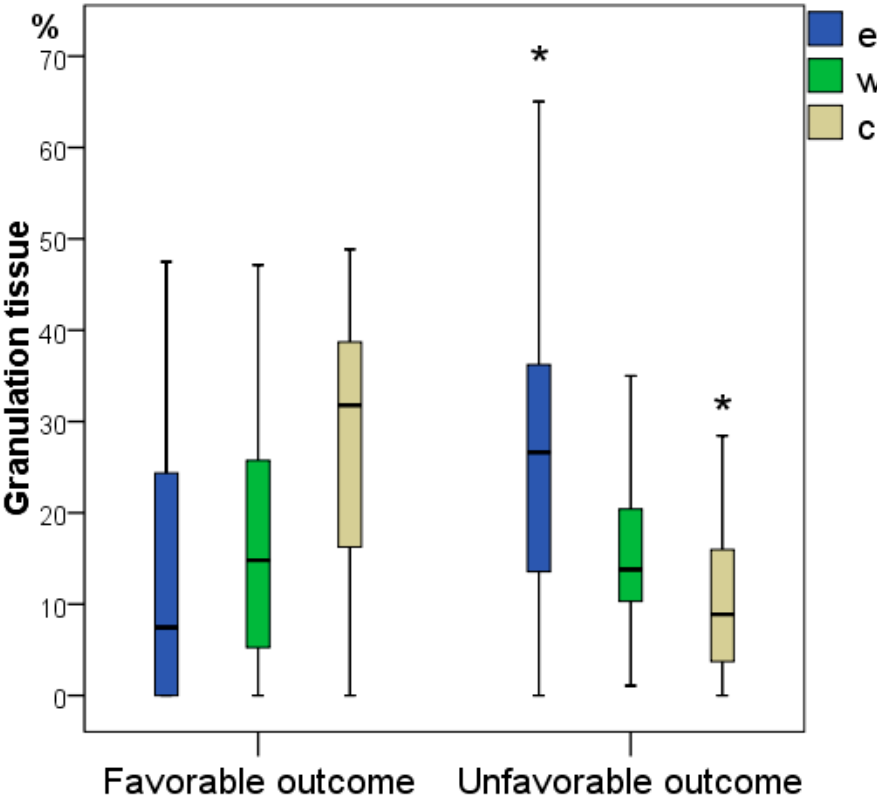
Figure 4. Frequency of representation of granulation tissue in different parts of wounds obtained during the primary surgical treatment for patients with a favourable and unfavourable outcomes of diabetic foot treatment (*—difference between groups in terms of outcome at p < 0.05; Mann–Whitney U test)